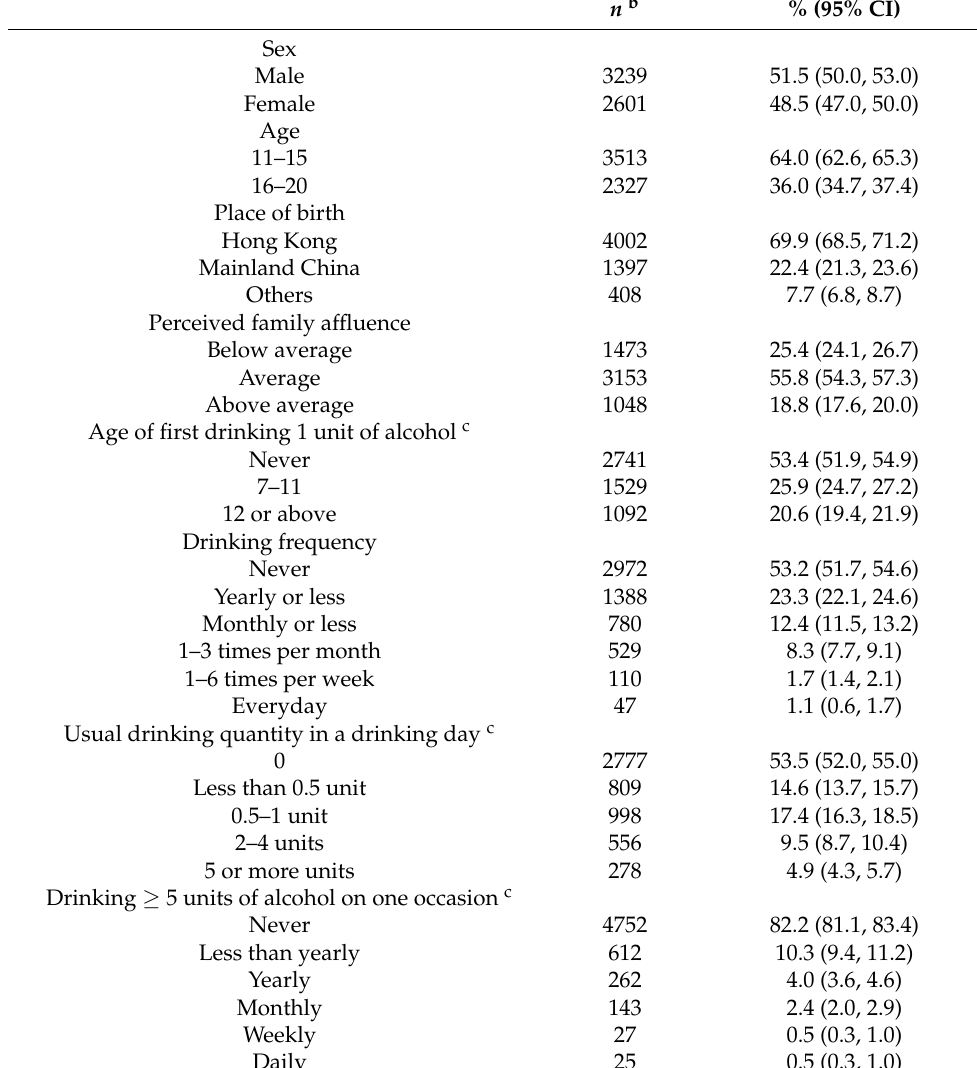
Table 1. Socio-demographic characteristics and drinking behaviors of 5840 participants a